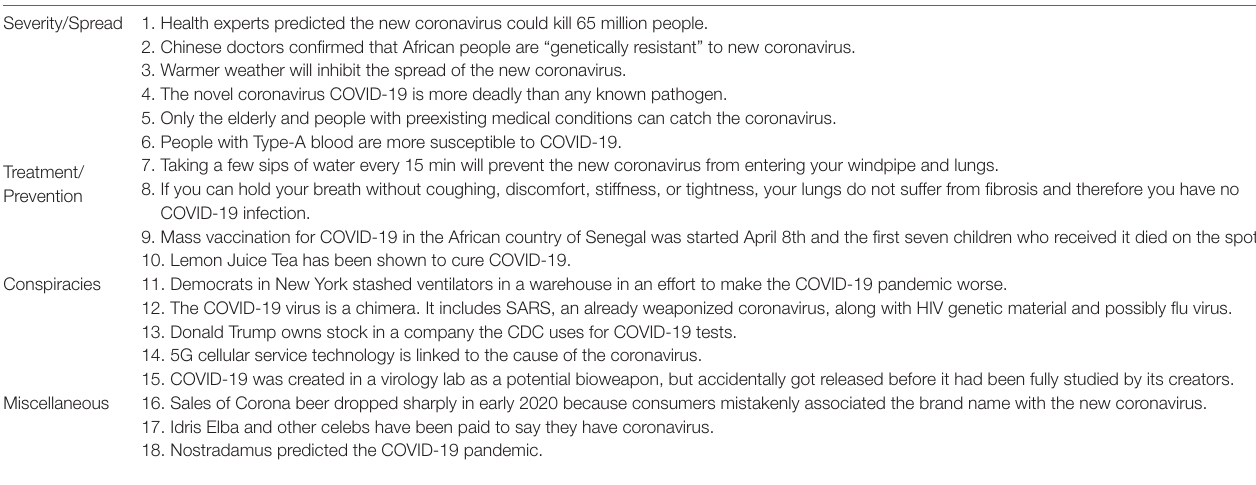
TABLE 1 | COVID-19 misinformation claims used in the